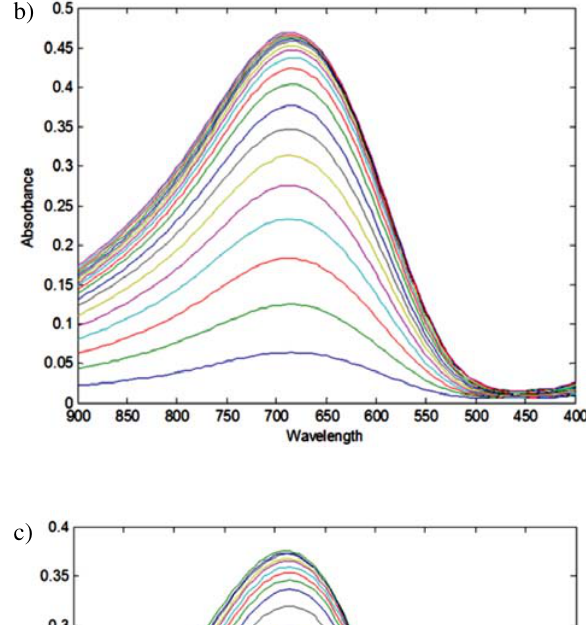
Figure 4. Spectroscopic titration curve of (a) E4.COOH; (b) D4.COOH; (c) P4.COOH with Cu 2+ ions at λ max = 680